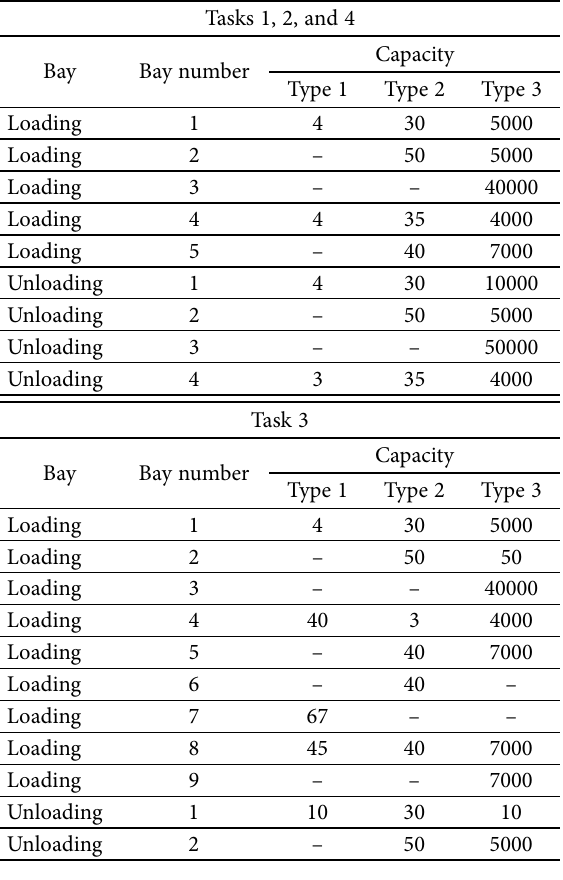
Table 4. Loading/unloading bays capacities for different cargo types